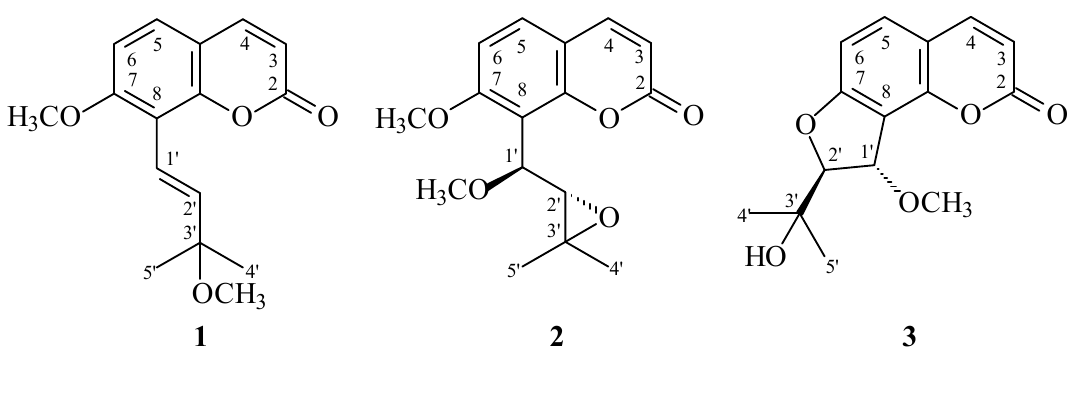
Figure 1. The chemical structures of new compounds 1 – 3 isolated from C. monnieri